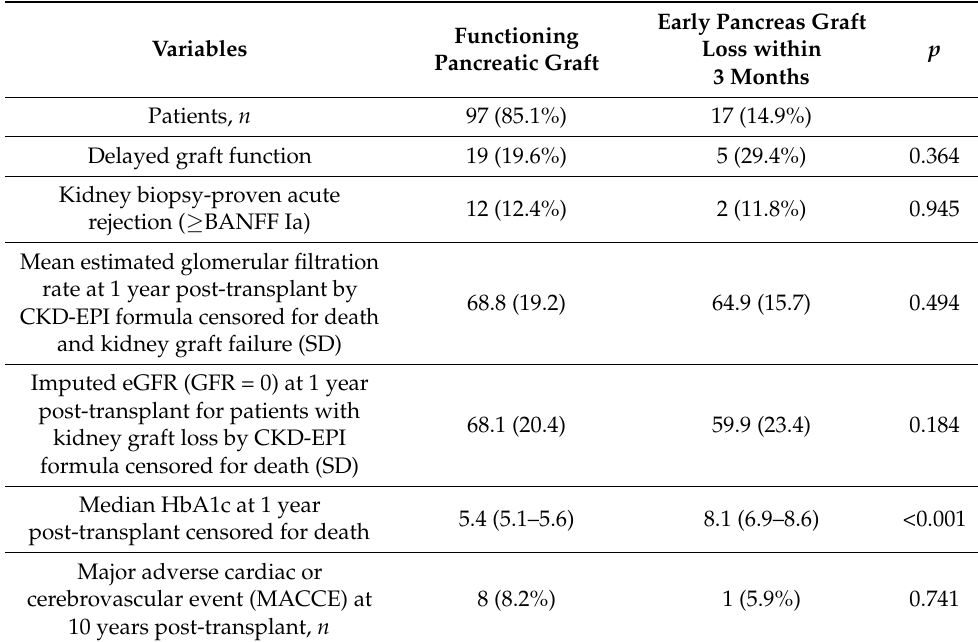
Table 4. Clinical endpoints with functioning pancreas graft vs. early pancreas graft